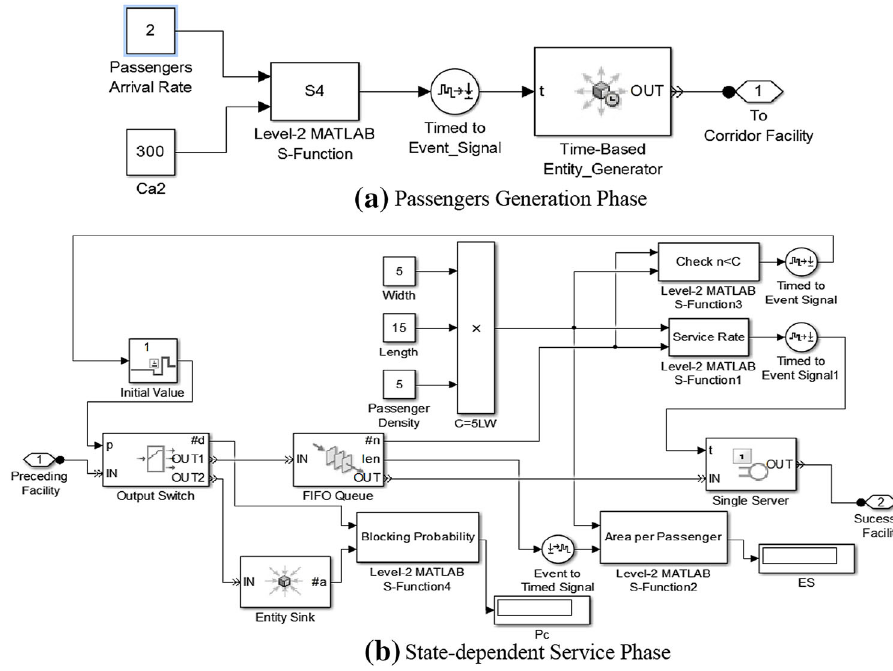
Fig. 4 PH/PH( n )/C/C discrete- event simulation model